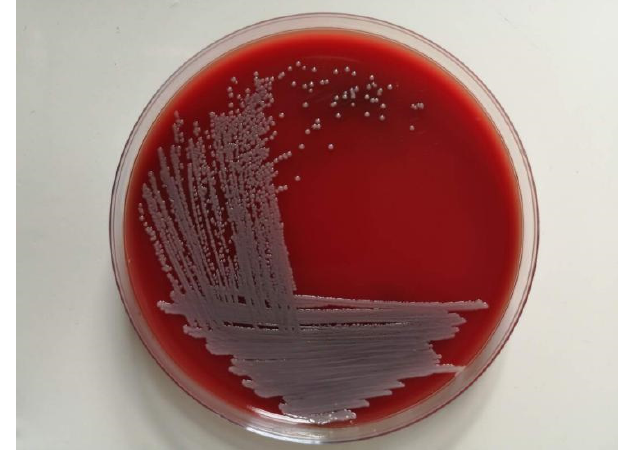
Figure 1. Purified bacterial colonies cultured on blood agar.